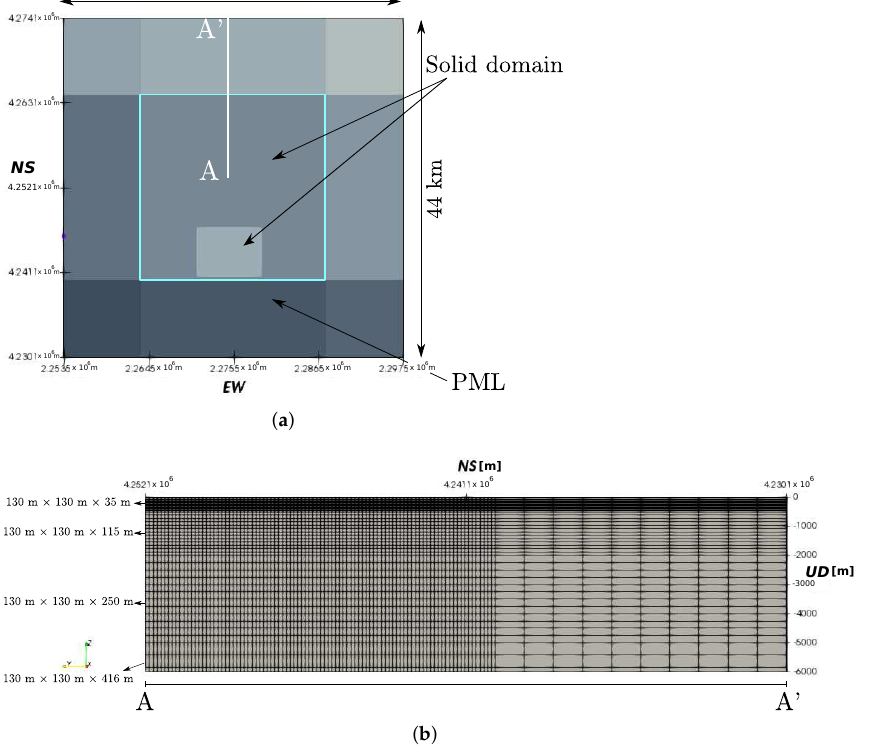
Figure 10. Details of the computational domain surrounding the Argostoli basin. ( a ) Top view of the domain of interest, including PML layers (flat surface topography). ( b ) Cut AA’ with associated element